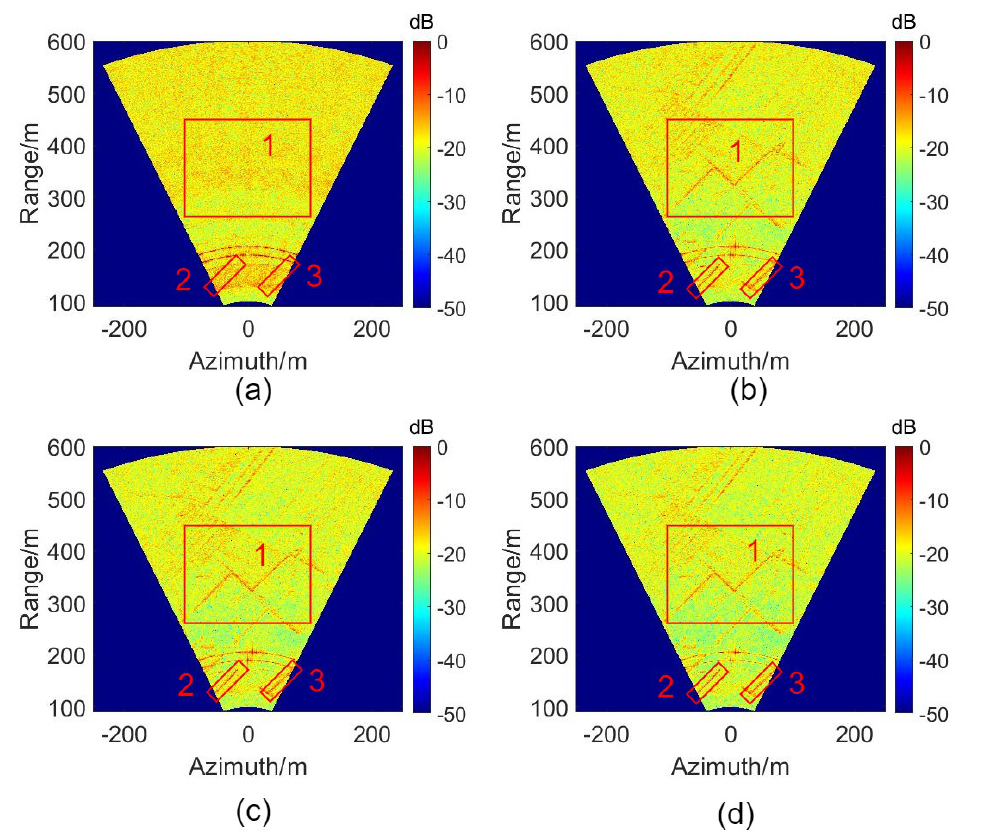
Figure 9. Experimental results. ( a ) BP imaging with initial phase error. ( b ) BP imaging with amplitude error. ( c ) BP imaging with position error. ( d ) BP imaging after compensation. Table 4. Experimental